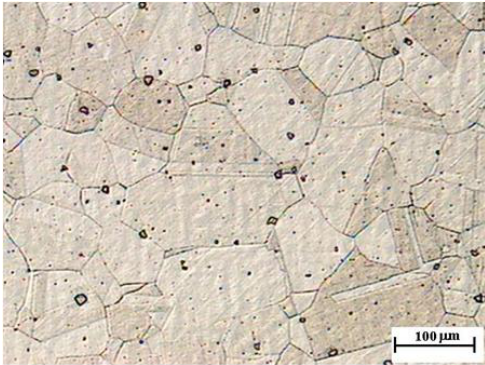
Figure 2. Optical micrograph of heat treated superalloy VAT 36. Magnification: 100×. Heterogeneous grain sizes and small amount of precipitates. Small twinned areas are observed.